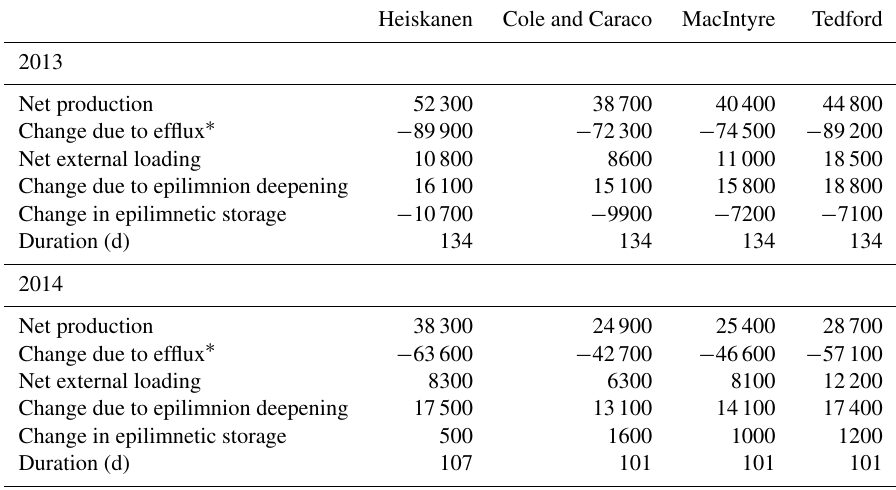
Table 4. Simulated CO 2 budgets (kgCO 2 ) for the epilimnion of Lake Kuivajärvi during summer stratification in 2013 and 2014 using different gas exchange models incorporated into MyLake C.